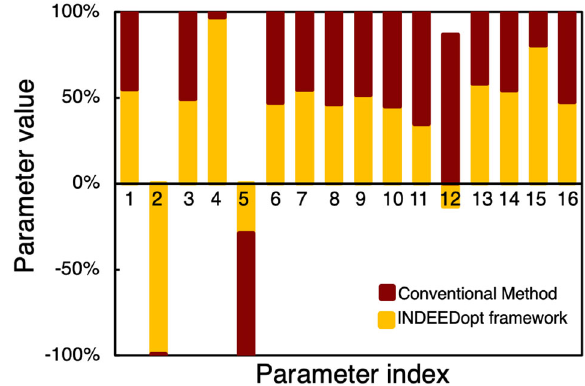
Fig. 6 The comparison of Ni – Cr force fi eld parameters optimized by different methods. The stacked bar graph representation of the difference between the parameter values in the nickel – chromium training set optimized using INDEEDopt with brute force and conventional method. The red represents the conventional, and yellow represents INDEEDopt version of the same parameter. The difference between the percentage values corresponds to the difference between predicted values by each method. The value 50% corresponds to a situation when both methods predict the same values. If the predicted parameter values are negative, then the percentage value is given as negative.